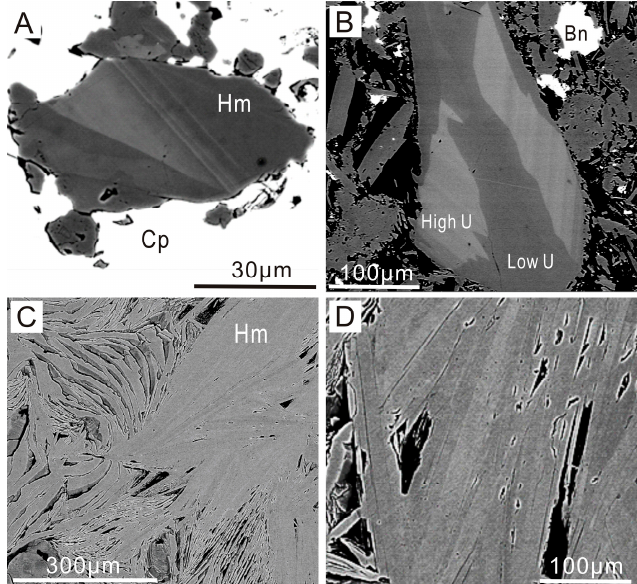
Figure 4. Back scattered electron images of U ‑ bearing zoned hematite. ( A , B ) Hematite (Hm) displaying oscillatory and sectorial zoning expressed as high ‑ U from Olympic Dam ( A ) and a second sample from another IOCG deposit in the Olympic Cu ‑ Au Province ( B) note differences in size, and coarser zones for the latter. Additionally note association with sulphides, bornite (Bn) and chalcopyrite (Cp), respectively; ( C , D ) low ‑ U hematite from Carajás (CUR ‑ 002) showing aggregates of hematite with zones containing U and W in the centers of the lamellae (brighter on BSE images).